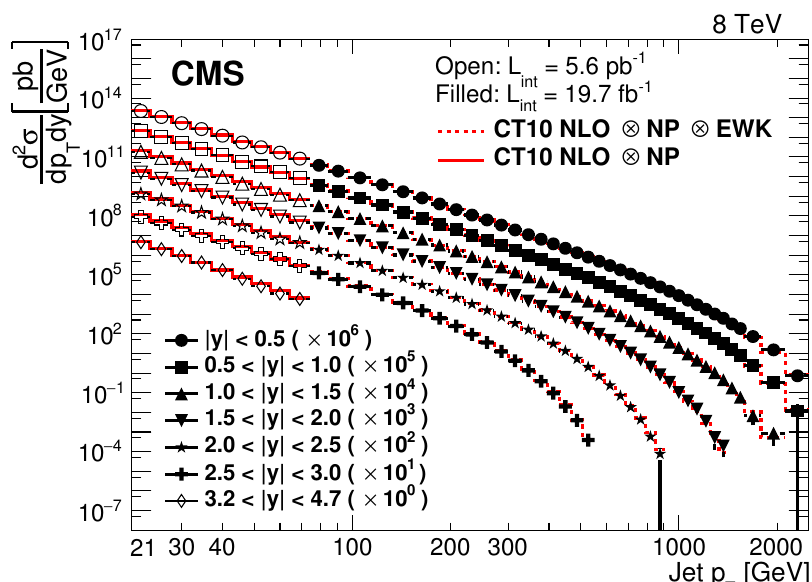
Figure 3 . Double-di(cid:11)erential inclusive jet cross sections as function of jet p T . Data (open points for the low- p T analysis, (cid:12)lled points for the high- p T one) and NLO predictions based on the CT10 PDF set corrected for the nonperturbative factor for the low- p T data (solid line) and the nonperturbative and electroweak correction factors for the high- p T data (dashed line). The comparison is carried out for six di(cid:11)erent j y j bins at an interval of (cid:1) j y j = 0 : 5.